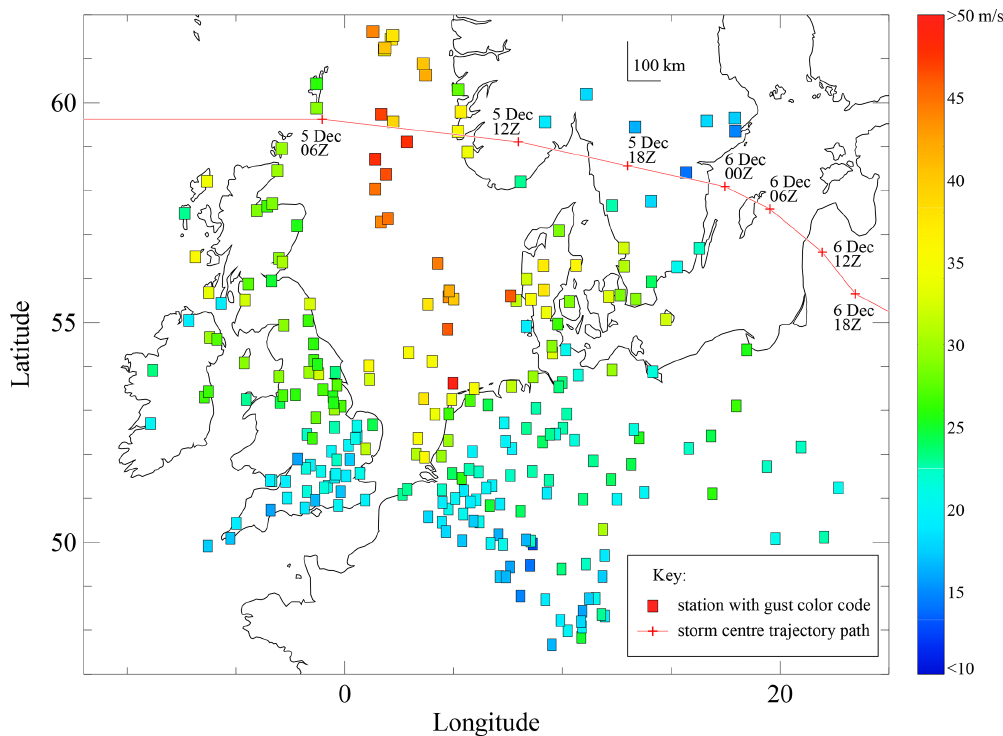
Figure 1. Maximum gusts over the two-day period 5–6 December 2013 from selected airports, offshore platforms, and coastal stations. The trajectory of the low pressure centre is indicated (digitized from the Supplement of Fenoglio-Marc et al., 2015).